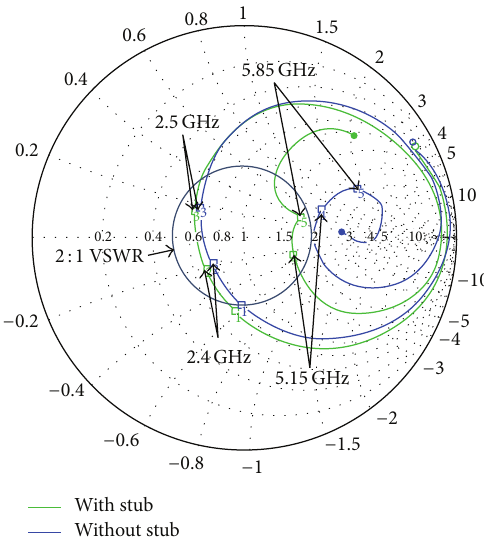
Figure 4: Simulated input impedance for the proposed antenna shown on Smith chart with (green) and without (blue) a tuning stub for frequencies 1.50–8.00